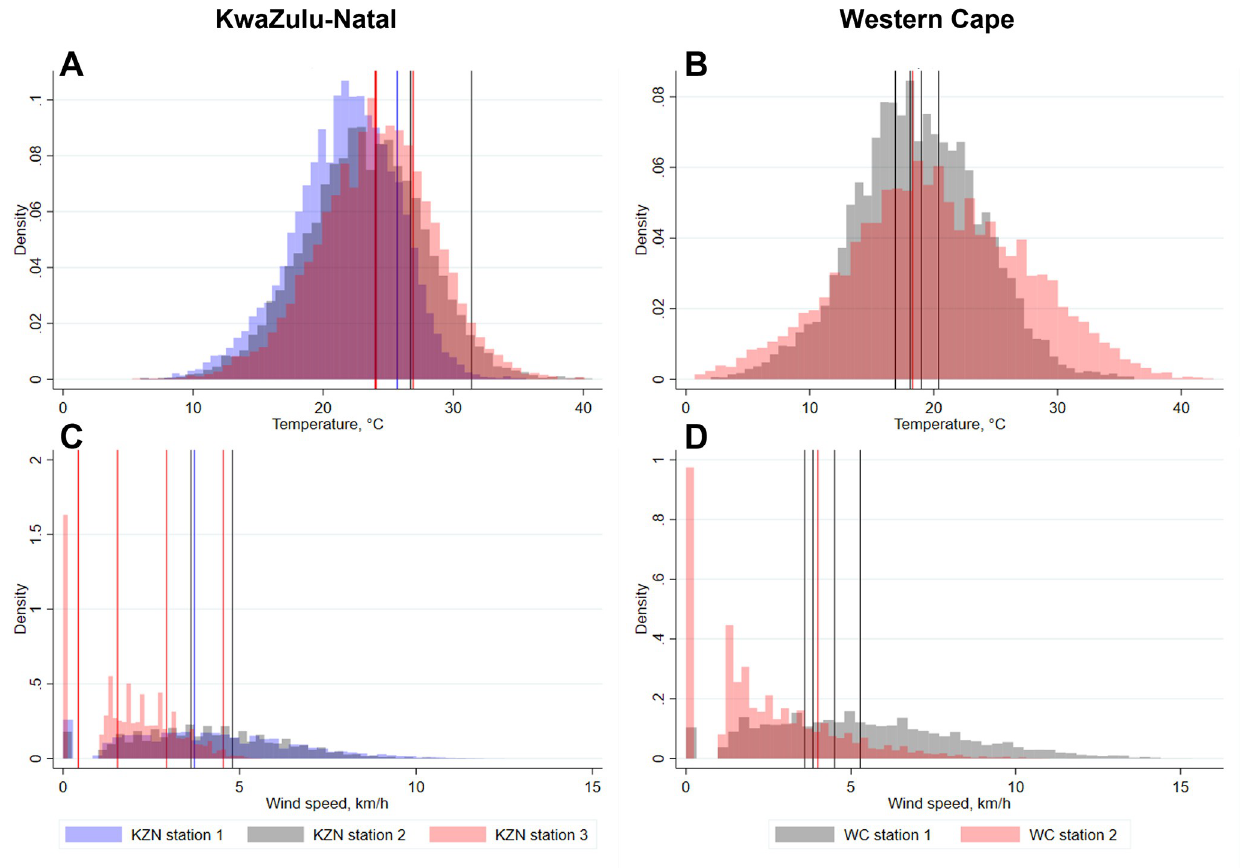
Fig 1. Histograms showing the distribution of temperatures and wind speeds in KwaZulu-Natal and Western Cape during working hours from January 2018–December 2020. Vertical lines show the mean temperatures and wind speeds on the 12 days when tracer gas release experiments were conducted. A: Temperatures in KwaZulu-Natal; B: Temperatures in Western Cape; C: Wind speeds in KwaZulu-Natal; D: Wind speeds in Western Cape. Vertical lines indicate mean temperature or wind speed at the weather station closest to each clinic during working hours on the day the data were collected. Colour of histograms and vertical lines corresponds to specific weather stations in each province. C: Centigrade; km/h: Kilometres per hour; KZN: KwaZulu-Natal; WC: Western Cape.